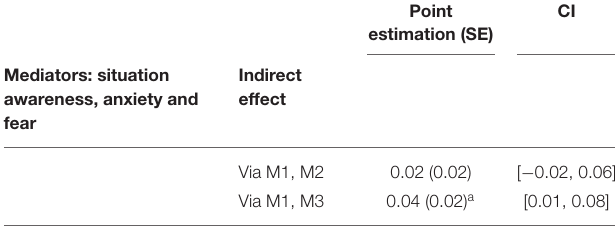
and fear (B = 0.87, p < 0.001) were positively associated with situation awareness. Thus, the results supported H2.